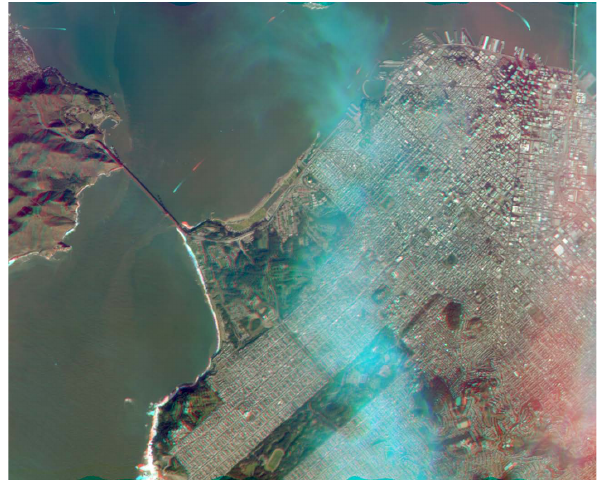
Fig. 16. Stereo anaglyph of San Francisco and a high-altitude cloud field generated using AirMSPI imagery at two view angles (approx- imately 4 ◦ forward and 28 ◦ aftward of nadir), acquired on 6 Jan- uary 2012. 660nm data from the near-nadir view are displayed in red; 445 and 555nm data from the aftward view are displayed in blue and green. The image is best viewed using red/cyan glasses with the red filter over the left eye to obtain a 3-D effect. The cloud parallax is too large for good image fusion, but surface topographic relief is apparent when the image is viewed with stereo glasses. North is toward the upper left. The motion of a boat approaching the Golden Gate Bridge is apparent due to the time lapse between the two images used to construct this anaglyph.